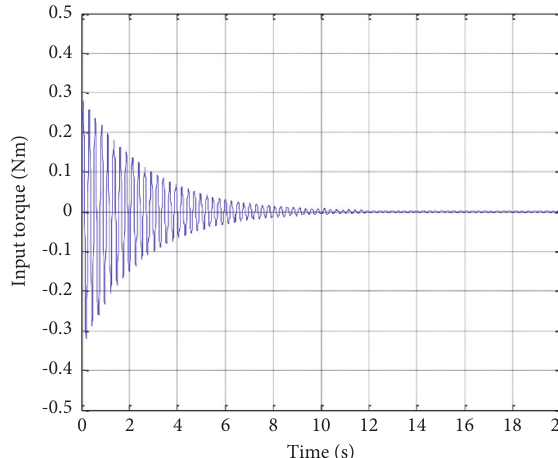
Figure 10: Torque input of the flexible manipulator.